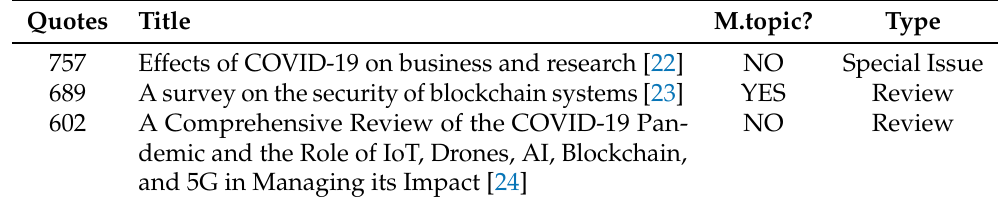
Table 7. Top 3 citations